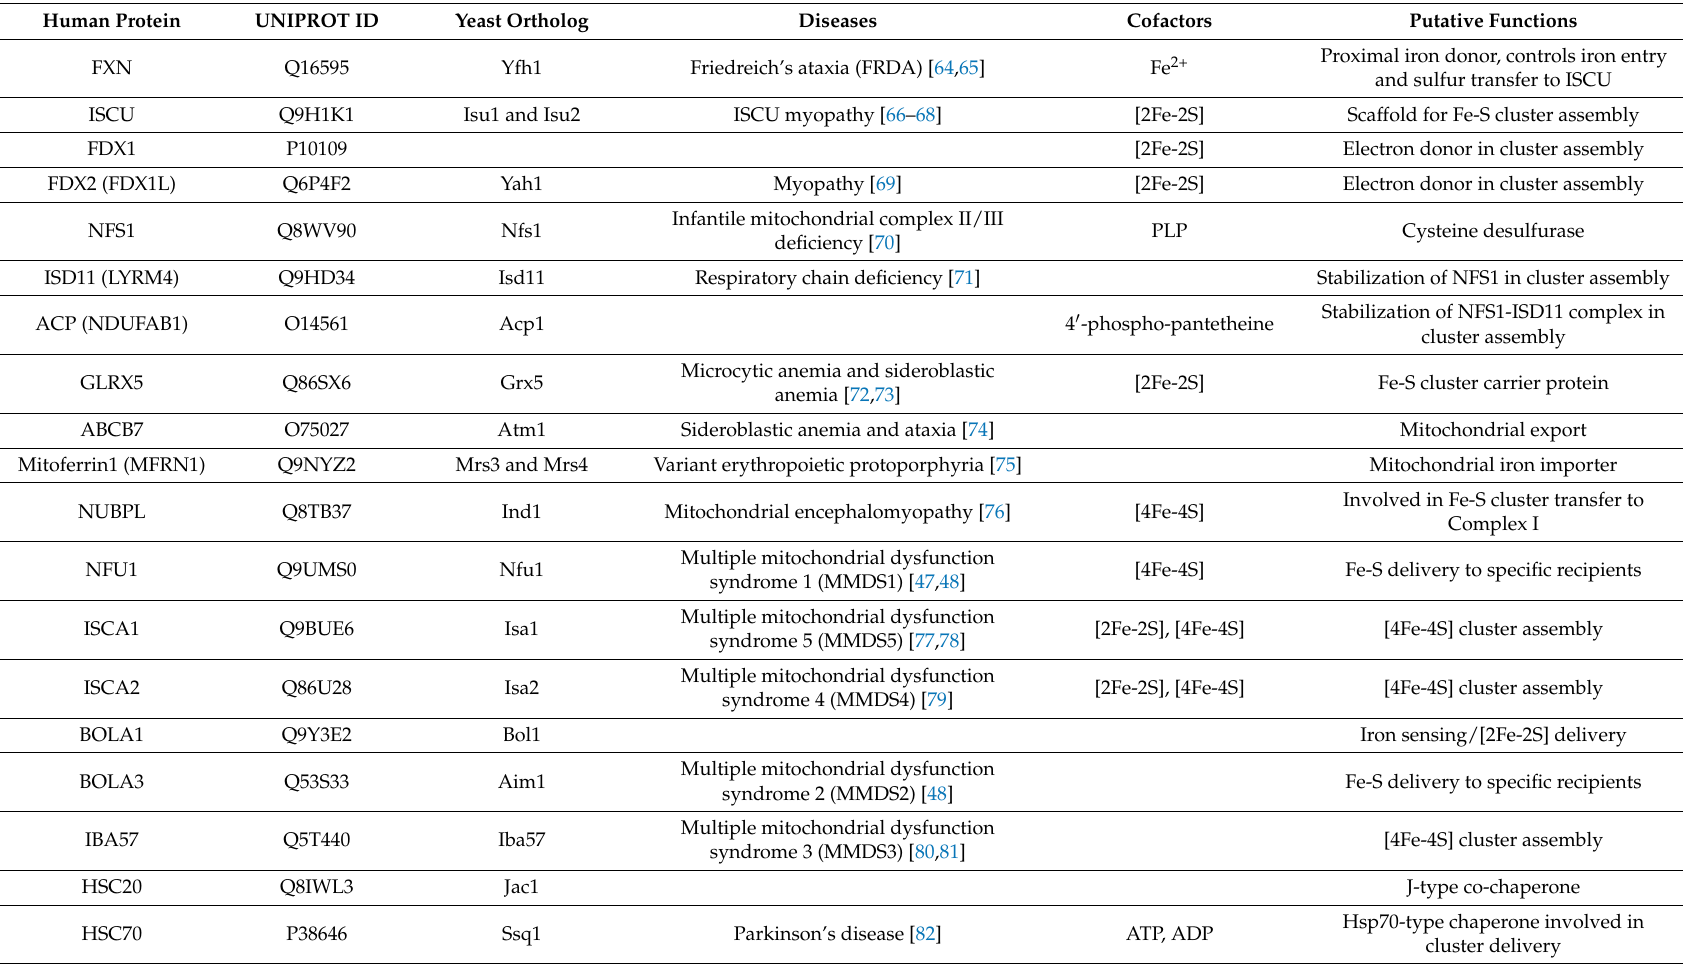
Table 1. Proteins involved in mitochondrial ISC machinery and related